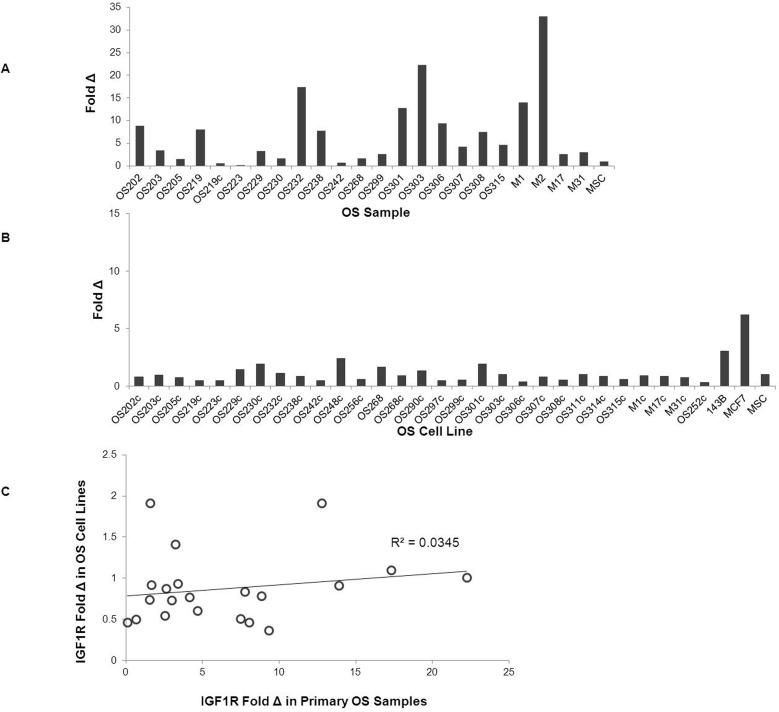
Relative IGF1-R mRNA Gene Expression in OS Primary Samples and Corresponding Cell Lines.Quantitative Real Time PCR detecting IGF1R mRNA expression was performed in OS primary samples (A) and OS cell lines (B). Grey bars represent relative quantification of IGF1-R expression using the ΔΔCT method using GAPDH as an endogenous control and MSC as a calibrator. Scatter plot comparing IGF1-R expression fold change in primary OS samples and their corresponding cell lines (C).